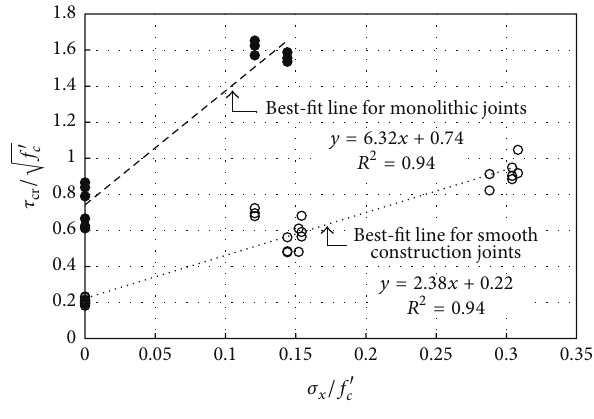
Figure 2: Regression analysis for 𝜏